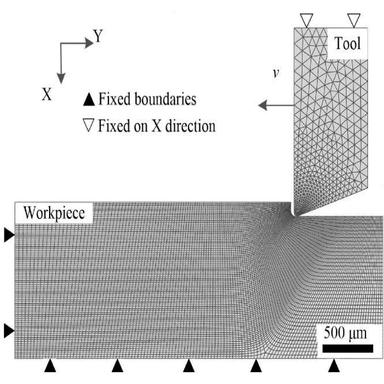
Boundary conditions of FEM cutting model. The bottom and left sides of the workpiece were fixed, whereas the tool was fixed only in the X-direction.